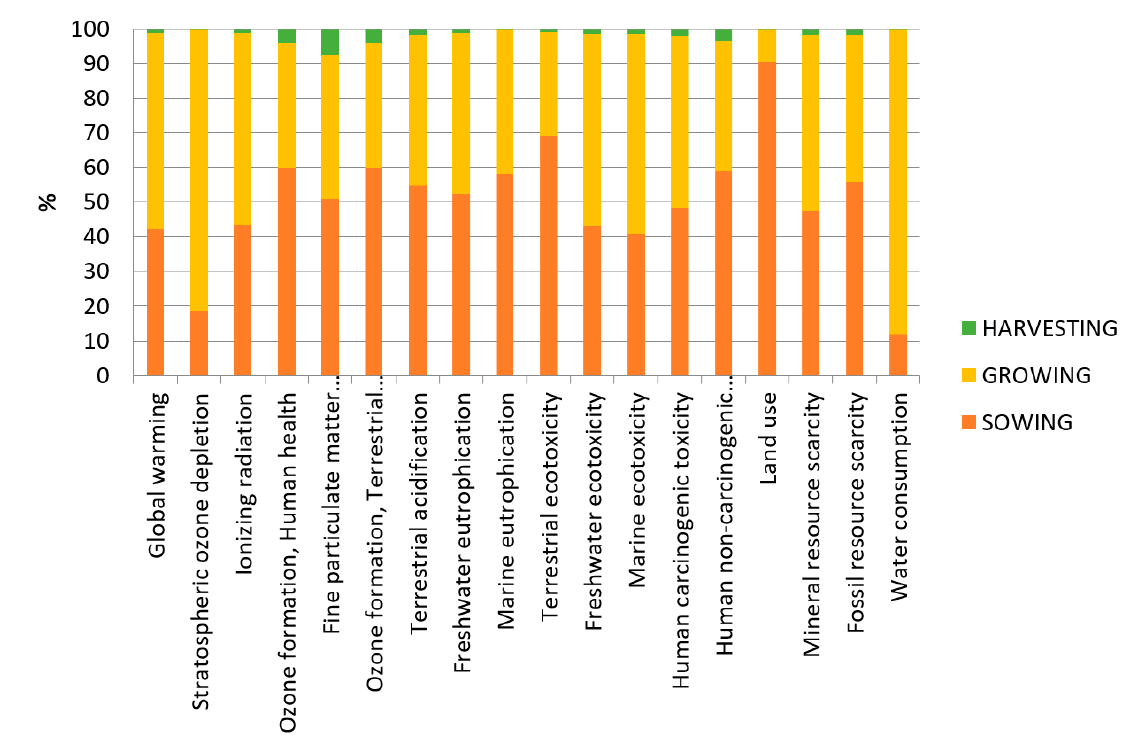
Figure 5. Environmental impact of selenium potato cultivation.